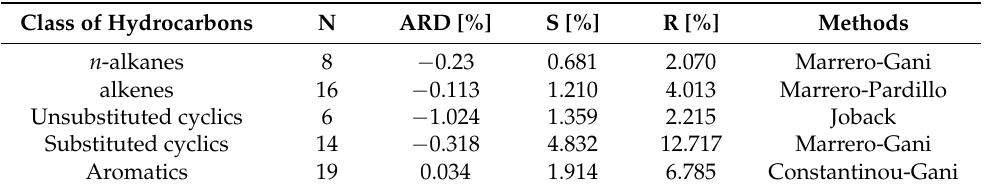
Table 8. Selected methods to predict the critical volume (V c ) of hydrocarbons classes ( n -alkanes, alkenes, unsubstituted cyclics, substituted cyclics, and aromatics), of all the compounds present in OLP, obtained by thermal catalytic cracking of palm oil at 450 ◦ C, 1.0 atmosphere, with 10% (wt.) Na 2 CO 3 [17].